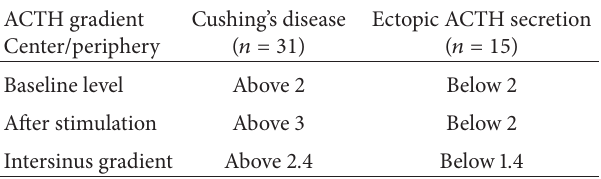
Table 2: Plasma ACTH gradient revealed by selective blood sam- pling from petrosal sinuses in the desmopressin stimulation test in patients with Cushing’s disease and ectopic ACTH